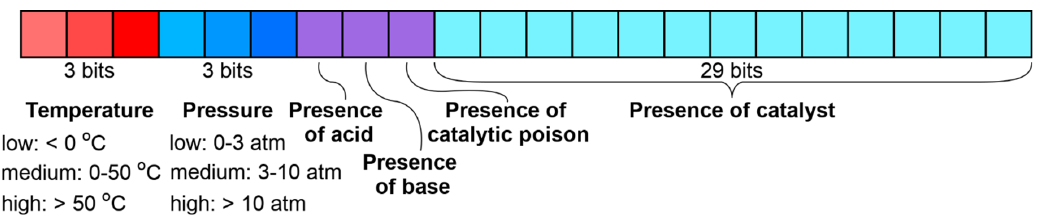
Figure 5. Condensed Graph of Reaction (CGR) generation. Figure 5. C ondensed Graph of Reaction (CGR) generation.